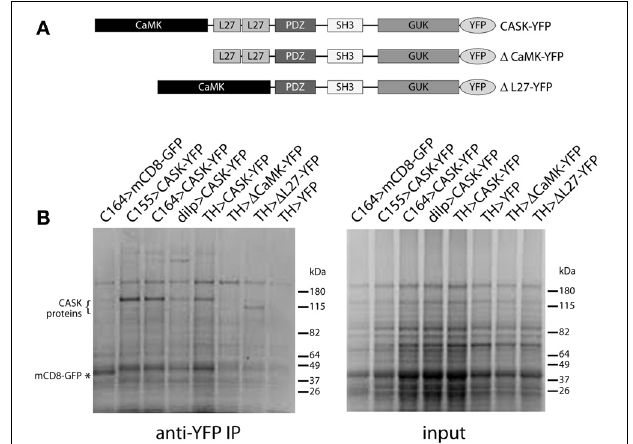
FIGURE 2 | Isolation of CASK-interacting proteins. (A) Schematic of CASK- β proteins used in this study. (B) Proteins eluted from anti-GFP beads were separated by SDS-PAGE and visualized by Coomassie staining. Genotypes are indicated above each lane. Bands can be seen at the correct molecular weights for CASK-YFP and CASK-YFP deletion mutants (indicated by “{”) and for control mCD8-GFP (indicated by “ ∗ ”). Identities of proteins were confirmed by immunoblotting (data not